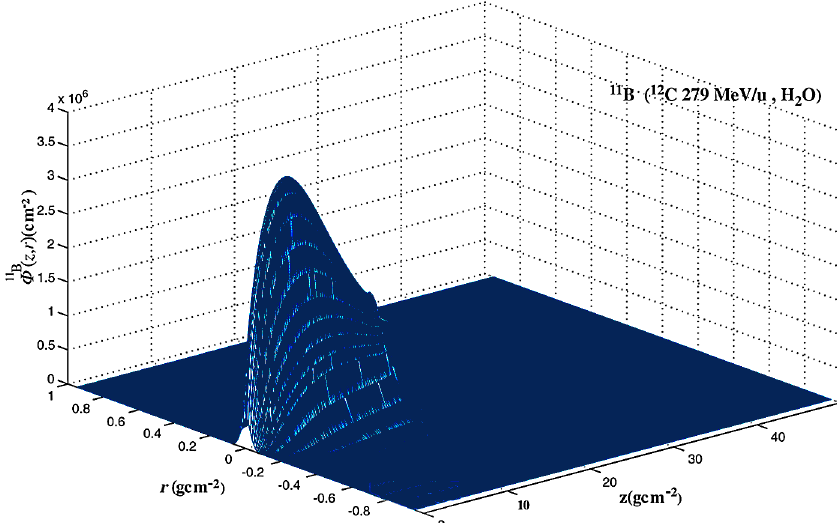
FIG. 6. The 3D distribution of the secondary 11 B ion fluence in a 0.6 mm diameter incident 12 C beam in water, as described by the present analytical Eq. (40). The reduced fluence at larger penetration depth is strongly correlated with the wider lateral spread and sudden disappearance at the practical range of the primary particles and a wider lateral spread of the 11 B fragments. The shape of the narrow depth fluence curve of the 11 B and 11 C ions follows the shape of their broad beam depth fluence curve in the entrance region, since there, due to the high energy, the spatial spread of both the primary and the generated fragments is low, cf. Eq. (41). Since the range of the boron fragment is longer than the primary particle a secondary tail of (cid:3) is seen.